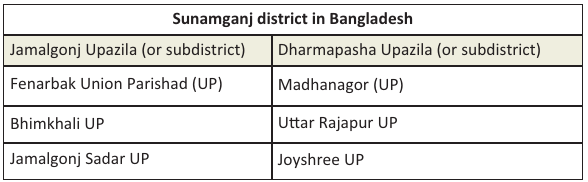
FIGURE 1-A1: List of sample local government union councils or Union Parishads.